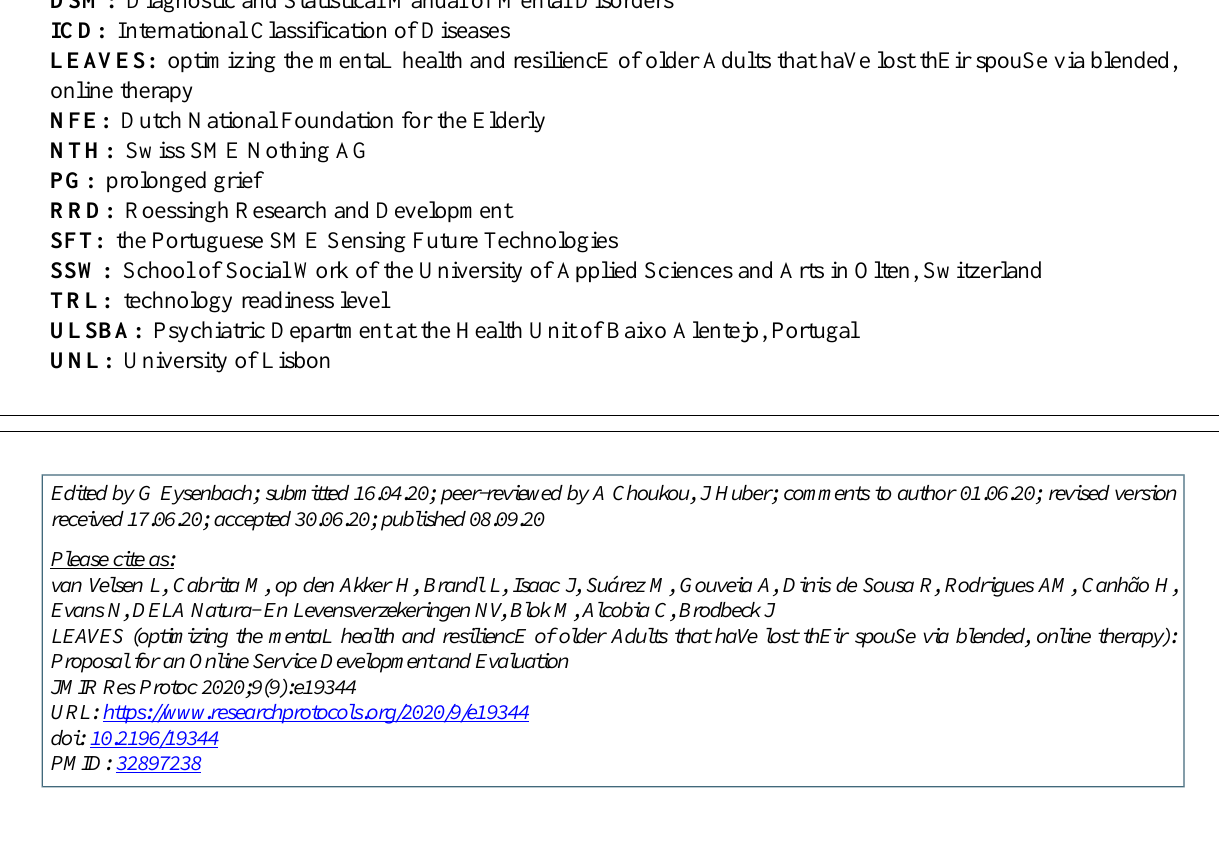
Abbreviations DSM: Diagnostic and Statistical Manual of Mental Disorders ICD: International Classification of Diseases online